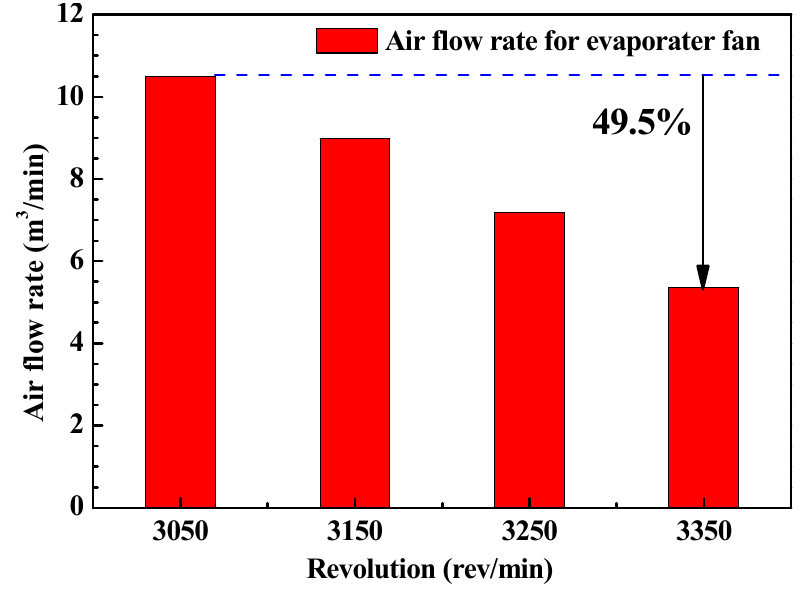
Figure 3. Air flow rate of the evaporator fan with fan rotation speeds.